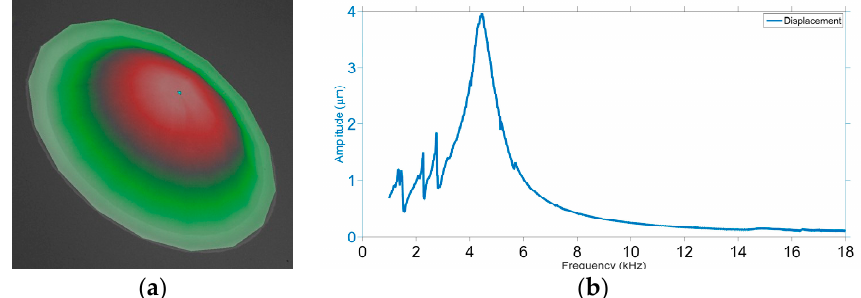
Figure 4. Plot ( a ) shows the measured output sound pressure in decibels with the corresponding displacement of the diaphragm, plot ( b ) shows the measured radiated pressure (mPa) from a single MEMS device and the pressure computed based on the displacement